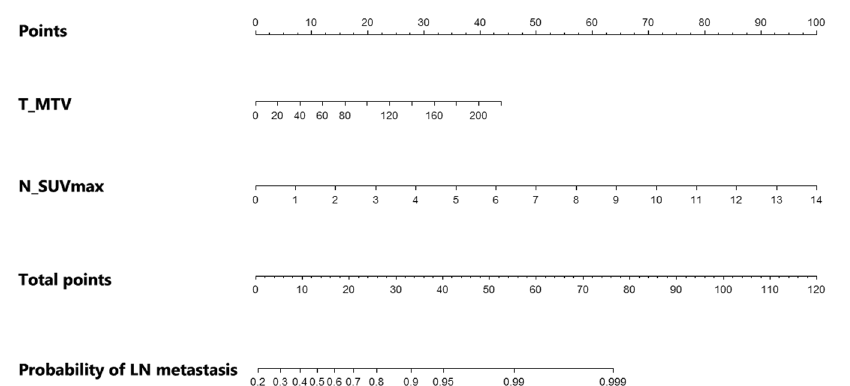
Figure 1. Nomogram for predicting the probability of regional LN metastasis using pretreatment [ 18 F]FDG PET/CT parameters. First, the number of points for each parameter – T_MTV and N_SUVmax – should be determined by drawing a vertical line from the exact value of variables to the points row. Subsequently, total points can be obtained by sum of two variables. The individual predictive probability of regional LN metastasis can be calculated by drawing a vertical line from the total points row to the probability of regional LN metastasis. LN = lymph node; [ 18 F]FDG = [ 18 F]Fluorodeoxyglucose; PET/CT = Positron Emission Tomography/Computed Tomography; T_MTV = metabolic tumor volume of primary tumor; N_ SUVmax = maximum standardized uptake value of regional